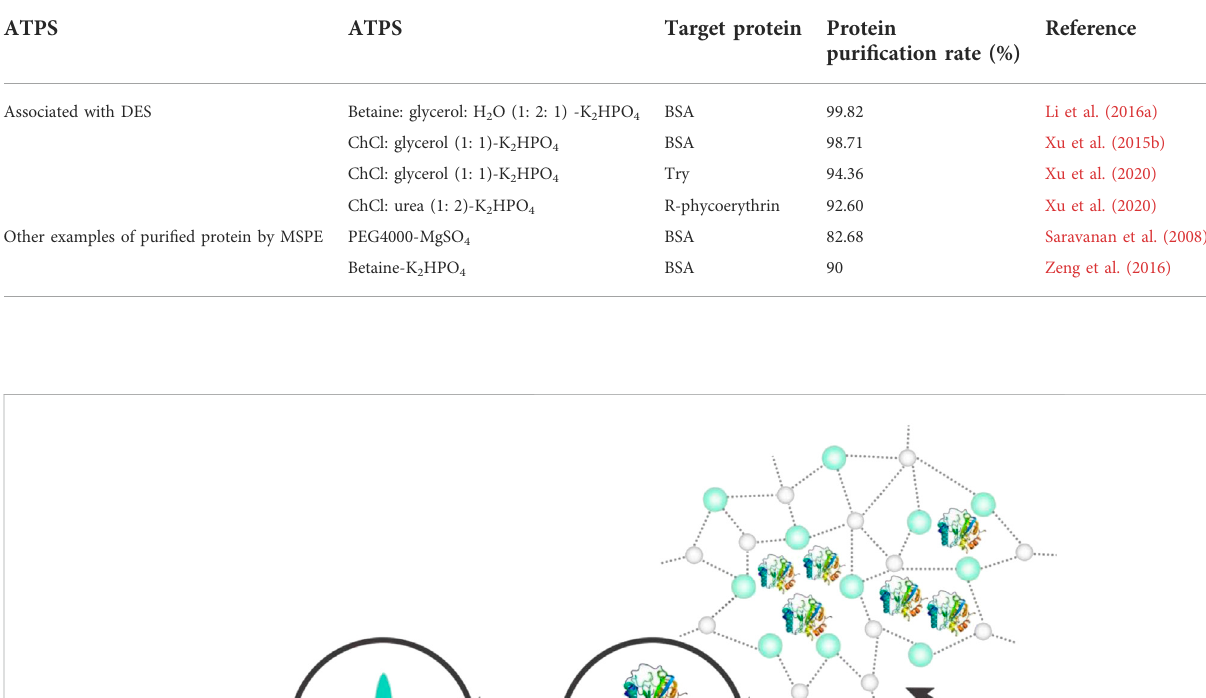
TABLE 5 Application of DES-based ATPS for protein puri fi cation.